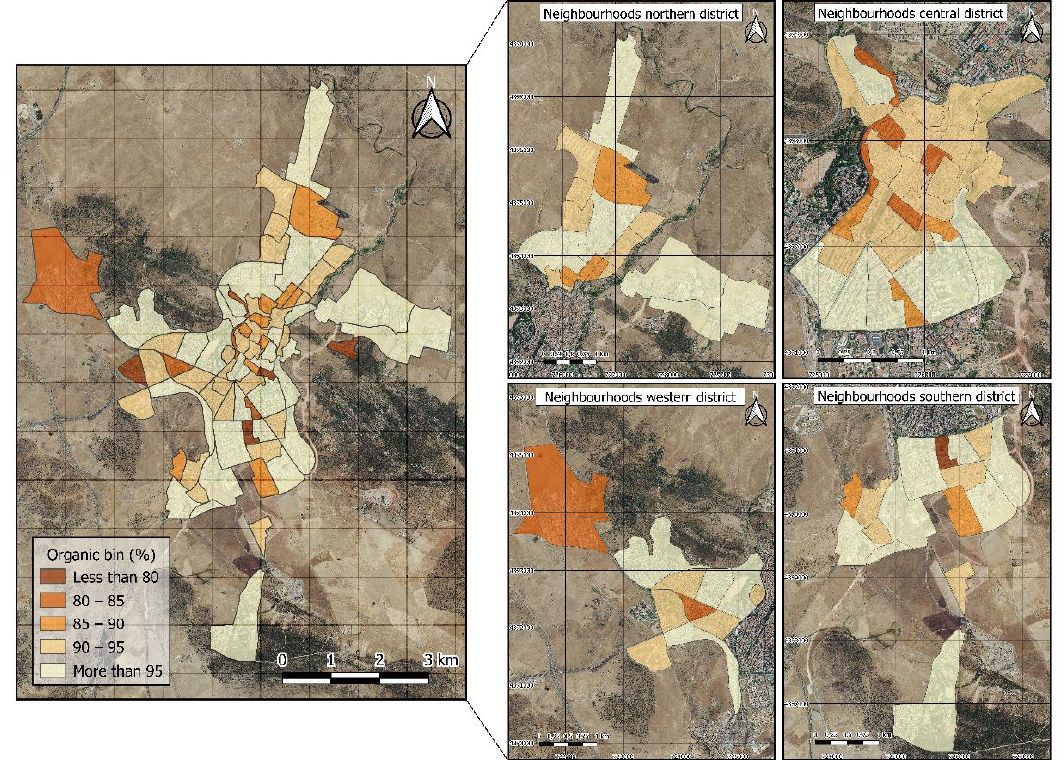
Figure 13. Urban land at more than 50 meters from an organic